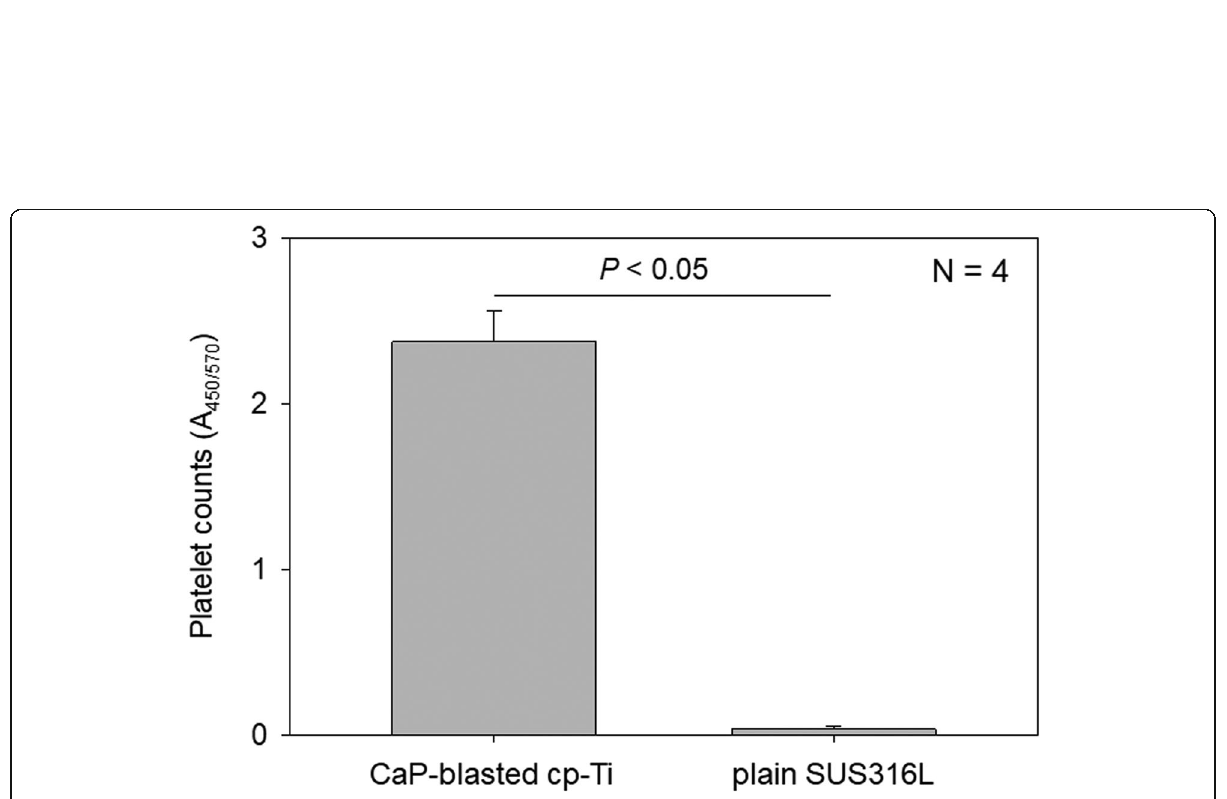
Fig. 8 Number of platelets adherent on CaP-blasted cp-Ti and plain SUS316L plates. After incubation for 60 min, the plates were rinsed and further incubated with CCK-8 for 90 min. The amount of converted formazan was quantified using a microplate reader at 450 nm. N = 4. P < 0.05 compared to